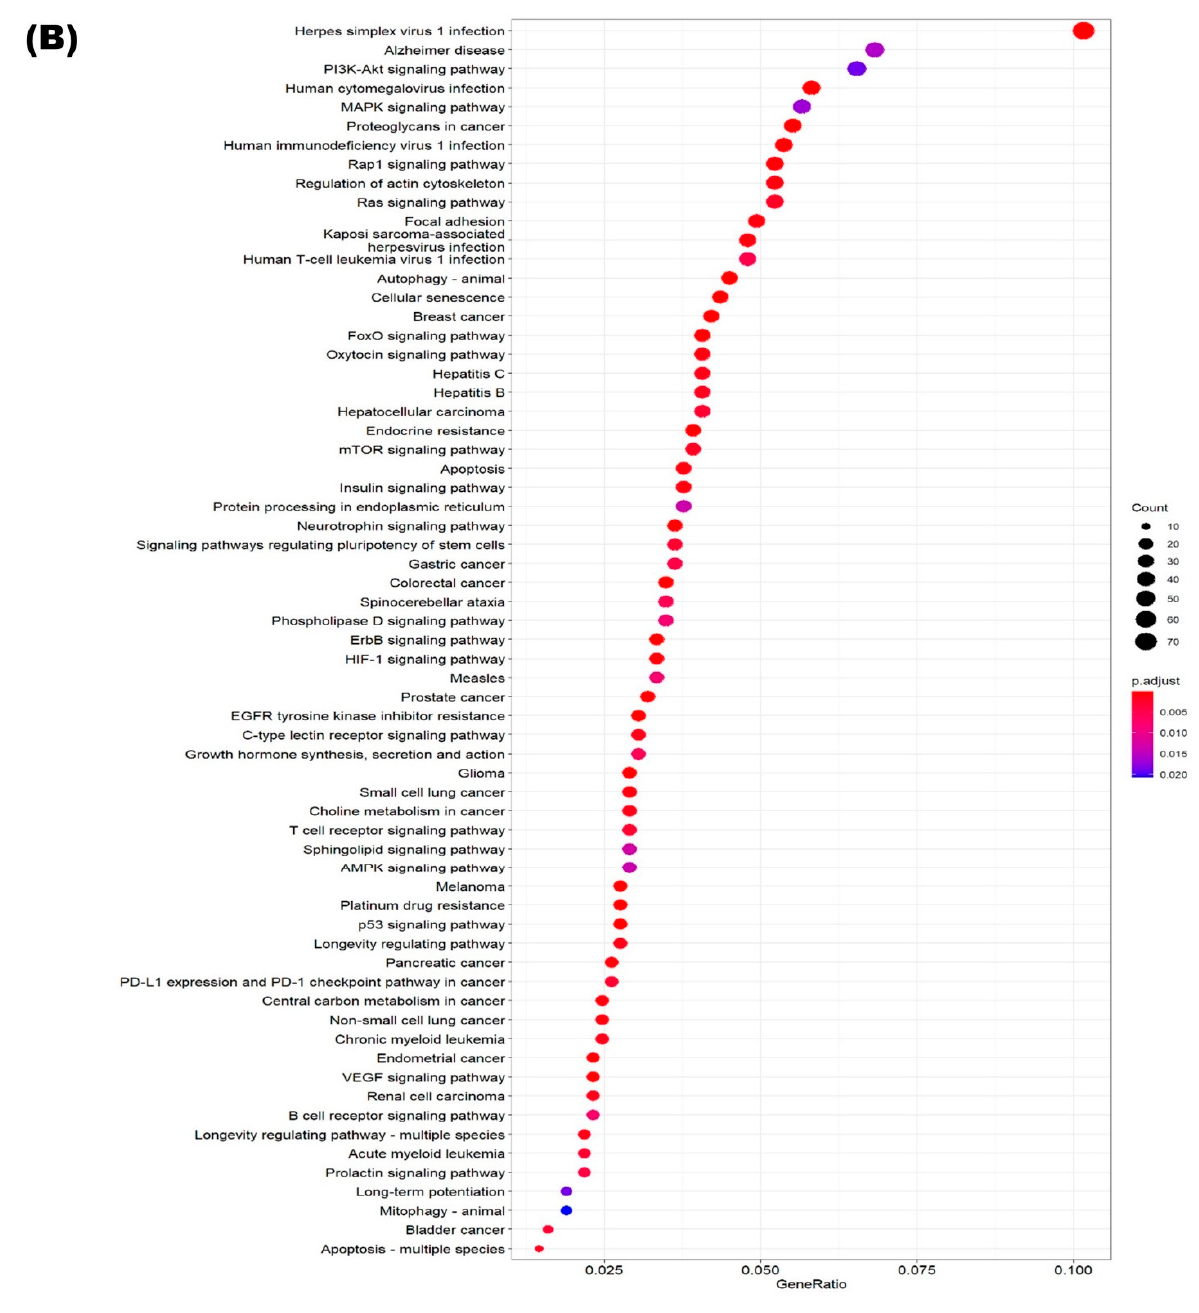
Figure 2. KEGG pathways enriched for DE miR target genes. ( A ) Pathways enriched for target genes of 20 DE miRs in the GACRS. Gene targets for miRs were identified using microT-CDS Diana, Target Scan & TarBase databases. ( B ) Pathways enriched for target genes from miRNet of 5 DE miRs generalizing to severe exacerbations in COPDGene.